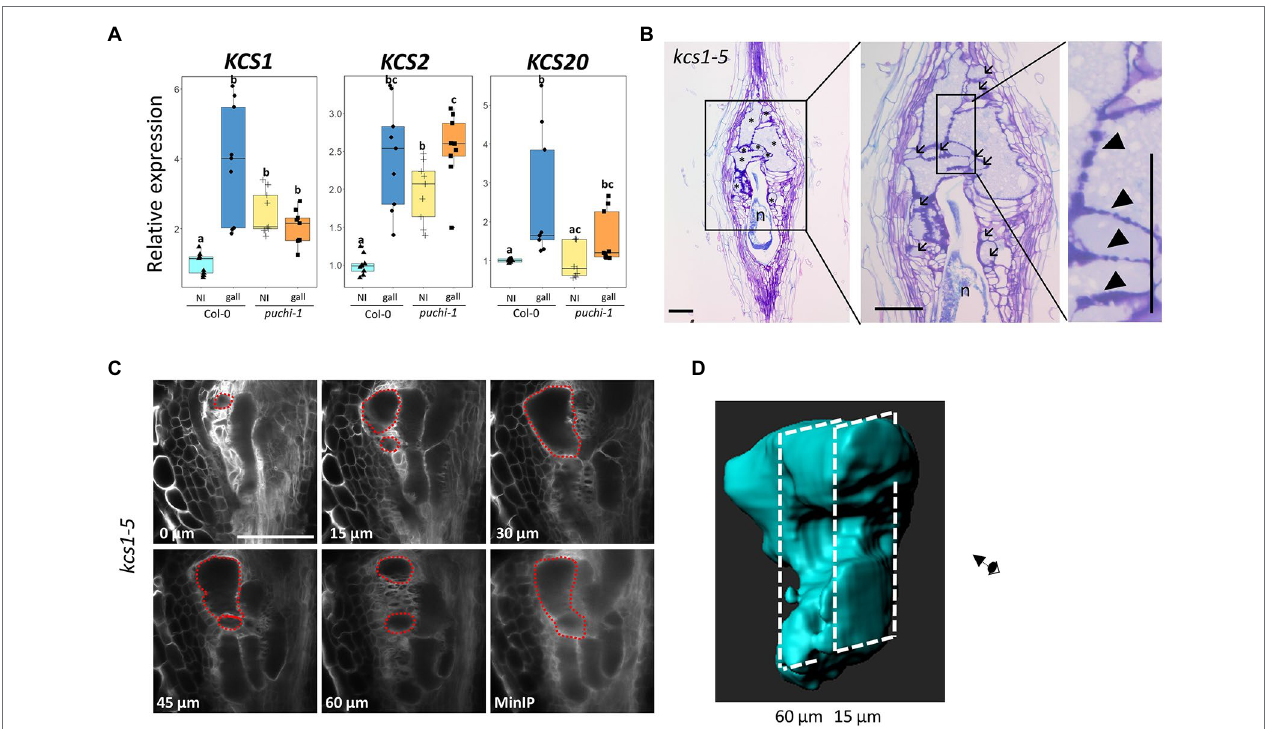
FIGURE 6 | Expression analysis of VLCFA biosynthesis genes after RKN infection and morphological analysis of kcs1-5 galls. (A) qRT-PCR results of KCS1, KCS2 , and KCS20 expression in WT (blue) and puchi-1 (orange) with uninfected roots (brighter shade) and 5 dpi galls (darker shade). Values are means of three technical replicates. Three biological replicates were performed with similar results. Alphabets denote significant differences between groups (Steel-Dwass’s multiple comparisons test, p < 0.05). (B) Toluidine blue-stained longitudinal sections of kcs1-5 galls at 14 dpi. Arrows denote aberrant GCs, and arrowheads denote thickened lobate GC cell wall. * denotes GCs; n denotes RKNs. Scale bars: 100 μ m. (C) Confocal optical sections of kcs1-5 galls stained with Calcofluor White at 7 dpi, and red dashed line outlines the same GC in different sections and the MinIP of the kcs1-5 optical section Z-stacks. Scale bars: 100 μ m. (D) 3D reconstruction of individual kcs1-5 GCs using the optical sections in (C)